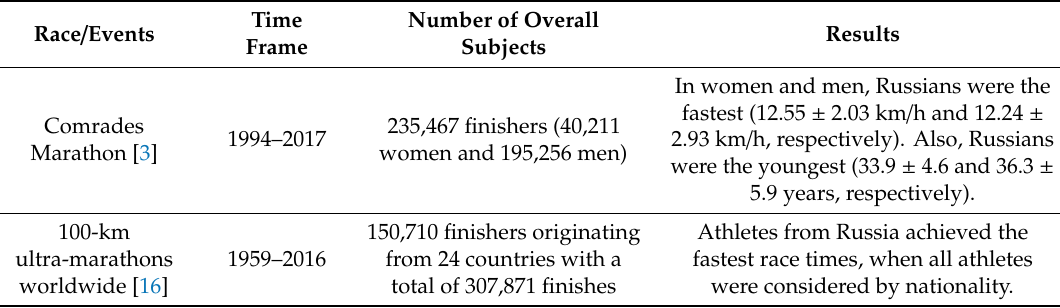
Table 2. Ultra-marathons with dominance of Russian